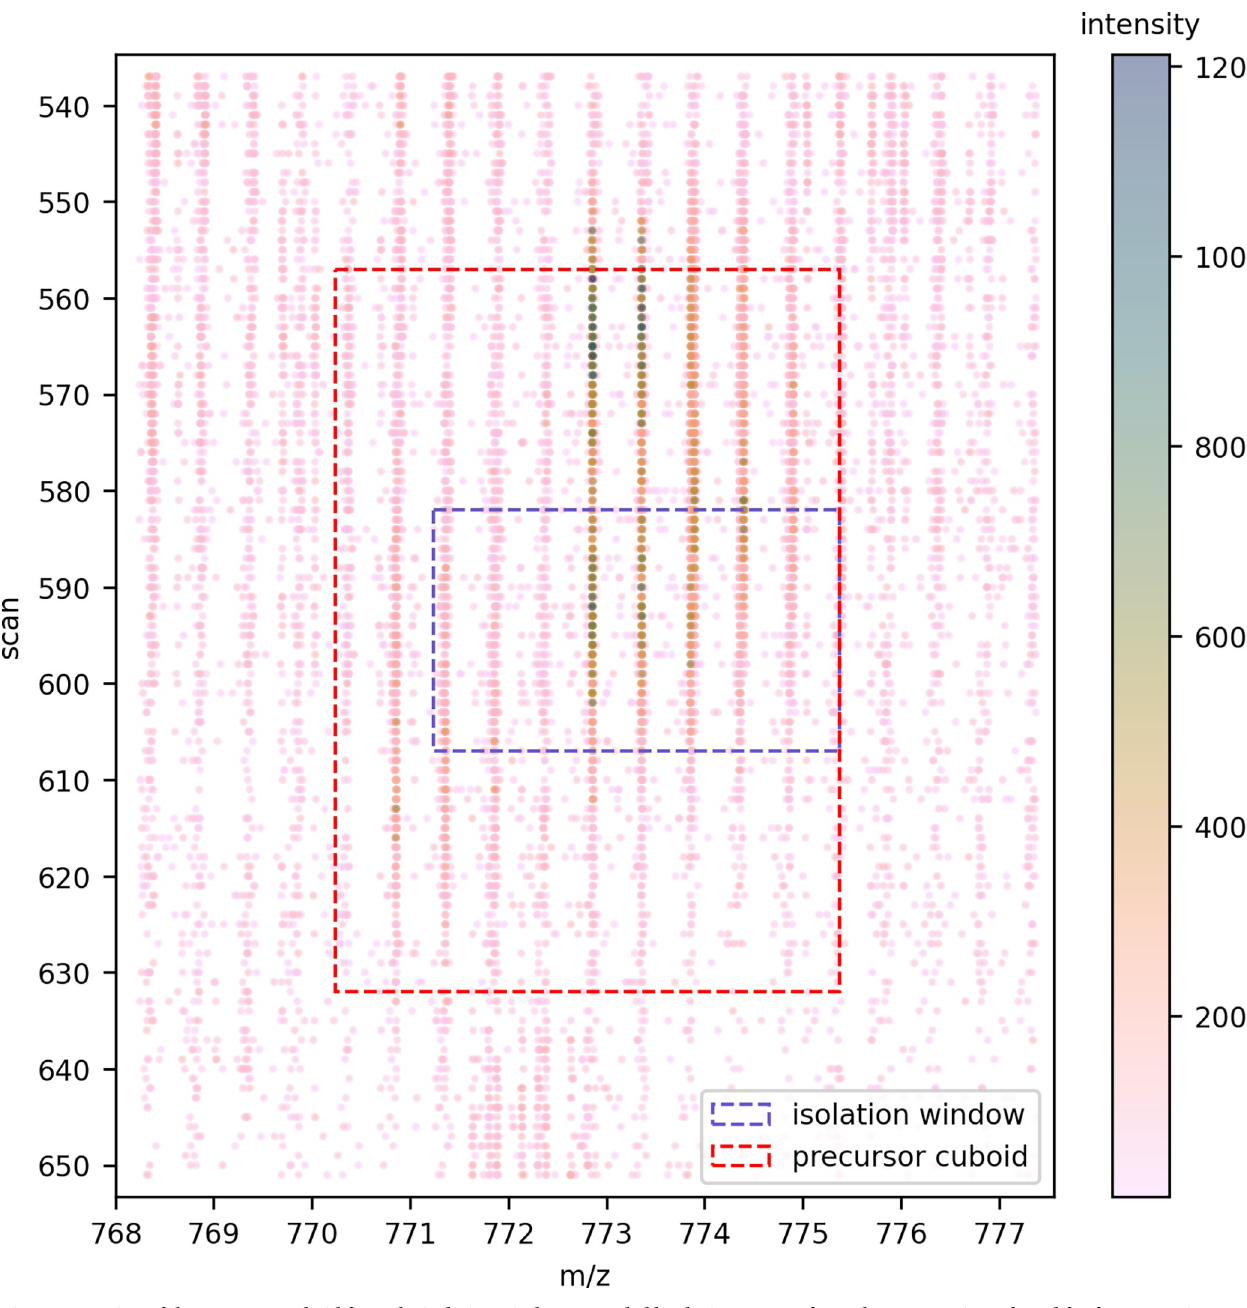
PLOS ONE | https://doi.org/10.1371/journal.pone.0271025 July 7,